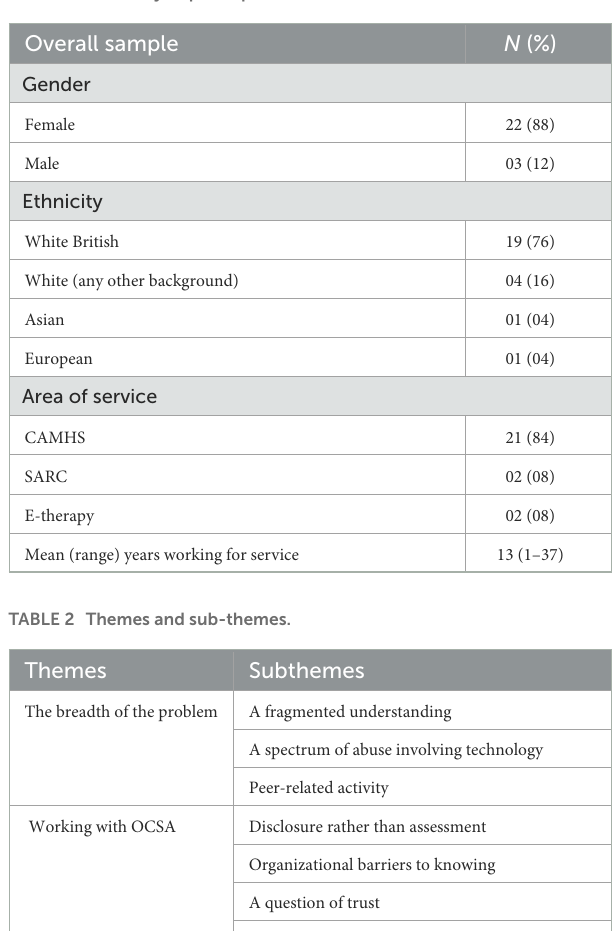
TABLE 1 Summary of participant characteristics.